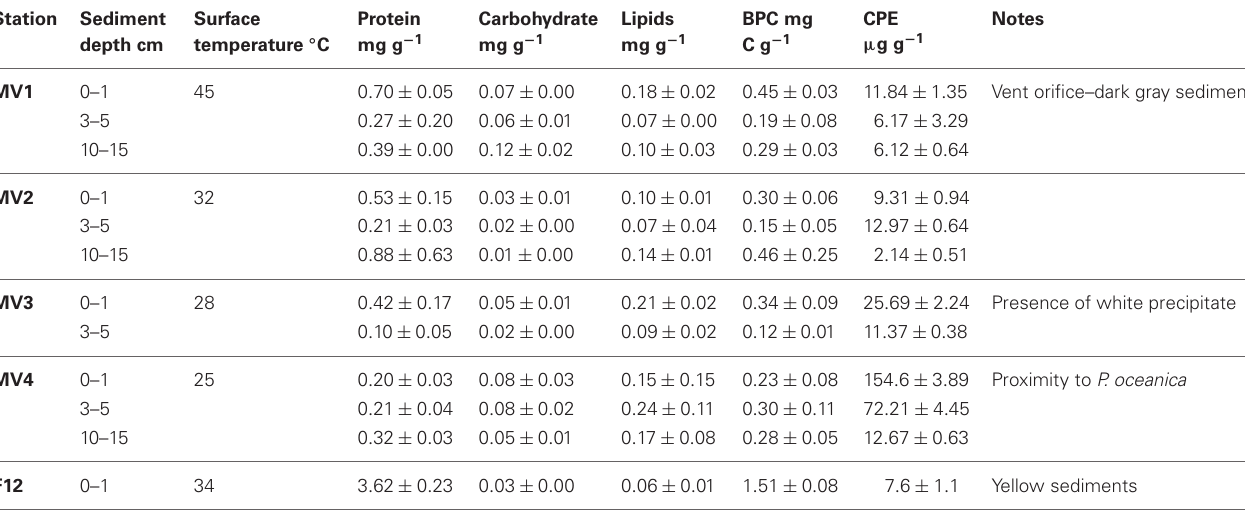
Table 1 | Sampled stations, temperature, organic matter content and main characteristic of the area. Station